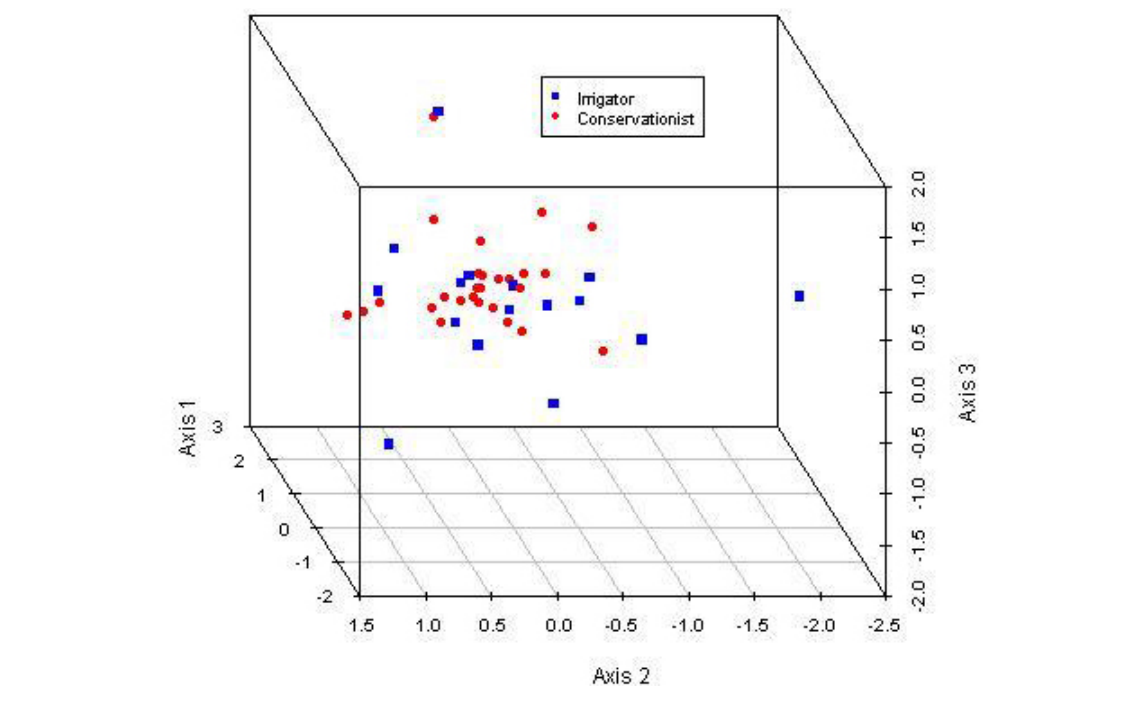
Fig. 6 . A three-dimensional MDS map of the similarities among conservationists and irrigators as to their perceptions of the consequences of the Crocodile River not flowing